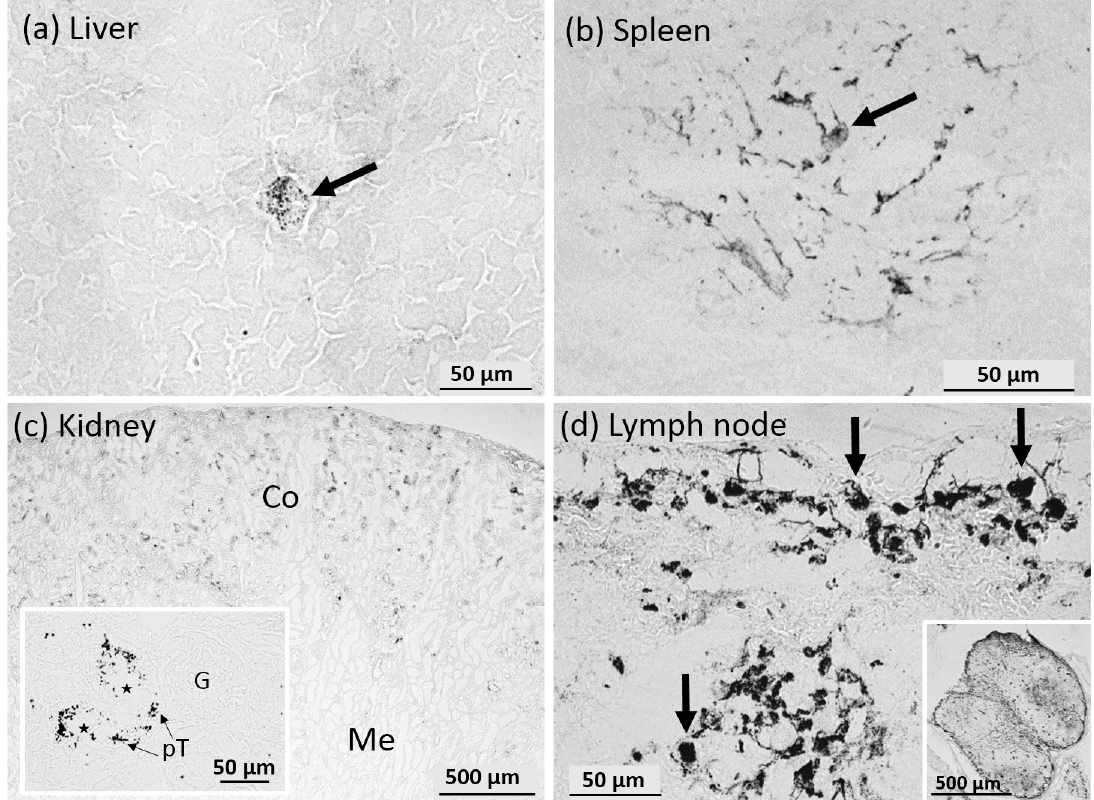
Figure 12. Autometallographic (AMG) staining of organ sections from a rat intratracheally instilled with 150 µg Ag50-PVP nanoparticles. ( a ) Liver parenchyma with dark silver grains concentrated in a cell (arrow) and some fine silver grains scattered throughout in the parenchyma; ( b ) spleen section with a typical roundish assembly of AMG-positive fibres centred by a cellular element (arrow); ( c ) kidney section showing representative parts of the cortical (Co) and medullary region (Me); (inset) the pronounced AMG-staining of the cortex is confined to proximal tubuli (pT, arrows), whereas glomeruli (G) are unstained.; ( d ) mediastinal lymph node; AMG-positive macrophage-like cells (arrows) occur in the marginal sinus and in the depth of the organ. The overview (inset) shows a prominent marginal staining and stained fibre elements spanning of two lymph nodes gathered for sectioning.